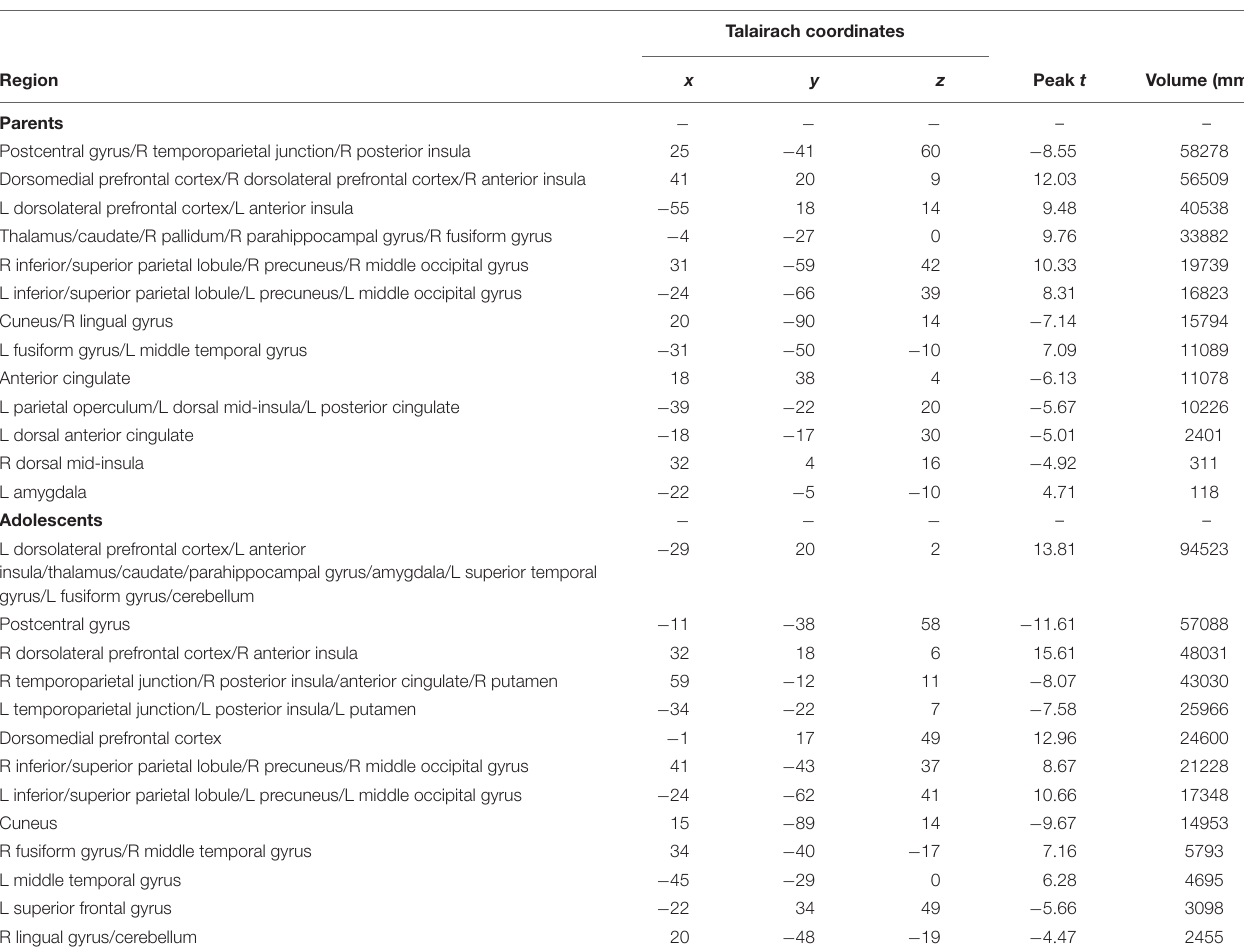
TABLE 2 | Within-group effects for “costly error” – “both correct”